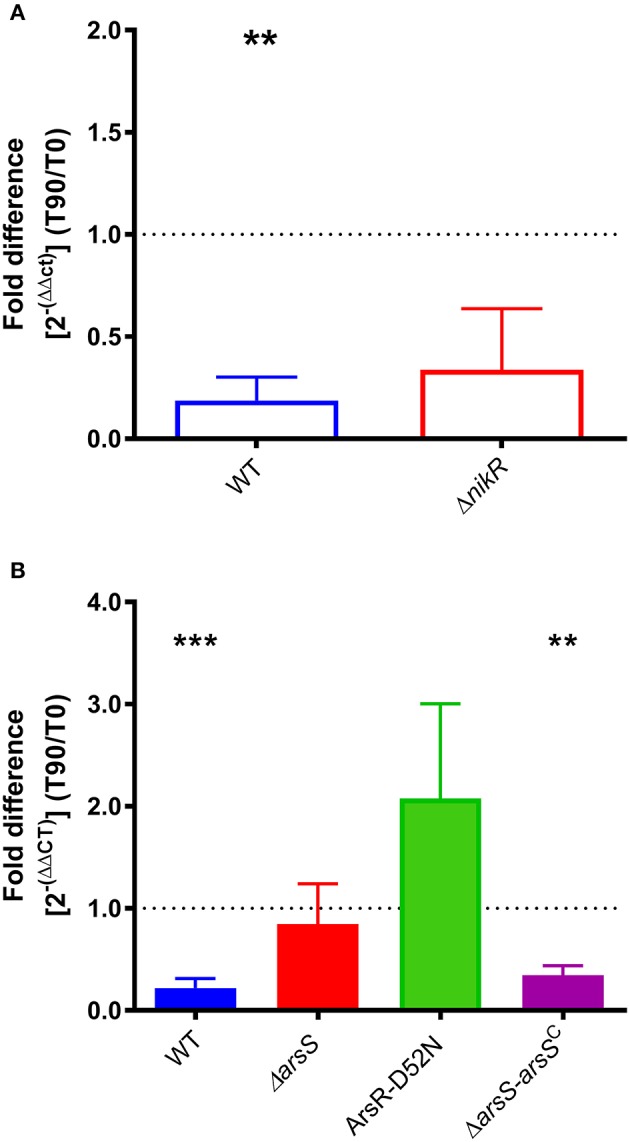
homB expression in response to environmental stimuli. (A) The expression of homB was evaluated in wild-type and ΔnikR following a 90 min exposure to 10 μM Ni2+. The fold difference between pre-shock (T0) and post-shock (T90) was calculated, and the mean fold difference of three biological replicates was plotted. The error bars show the standard error of the mean. A dotted line is plotted at 1 to indicate no fold difference in expression between pre-shock and post-shock expression. A significant decrease in expression was observed in the wild-type strain following exposure to 10 μM Ni2+ (p = 0.0047). (B) The expression of homB was evaluated in response to a 90 min shock at pH 5 in wild-type, ΔarsS, ArsR-D52N, and ΔarsR-arsSC. The fold difference between pre-shock (T0) and post-shock (T90) expression was calculated and plotted. A dotted line is plotted at 1 to indicate no fold difference homB expression following pH shock. Each bar represents the mean of a minimum of three biological replicates and error bars display the standard error of the mean. A significant decrease in homB expression was observed in wild-type (p = 0.0004) and ΔarsR-arsSC (p = 0.0021). Asterisks indicate significant changes in homB expression (**p < 0.01, ***p < 0.001).